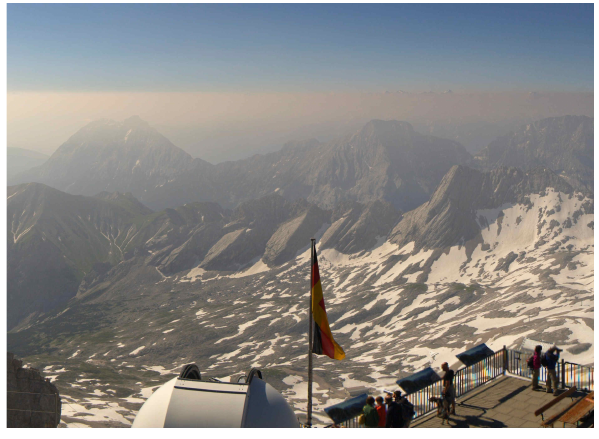
Figure 12. View from the Zugspitze summit approximately to the south on 16 July 2013, at 09:00CET; the Canadian fire plume fully hits the summit, but the main part misses Hohe Munde (2662ma.s.l., to the left, distance 10.6km). At the horizon, to the right, the summits of the central Alps, reaching 3774ma.s.l. (Wildspitze, Austria), appear just above the smoke layer (difficult to discern without magnification). The Schneefernerhaus station is slightly outside the picture (to the right). Source: http://zugspitze. panomax.at (copyrighted), courtesy of visualisierung und informa- tionstechologie